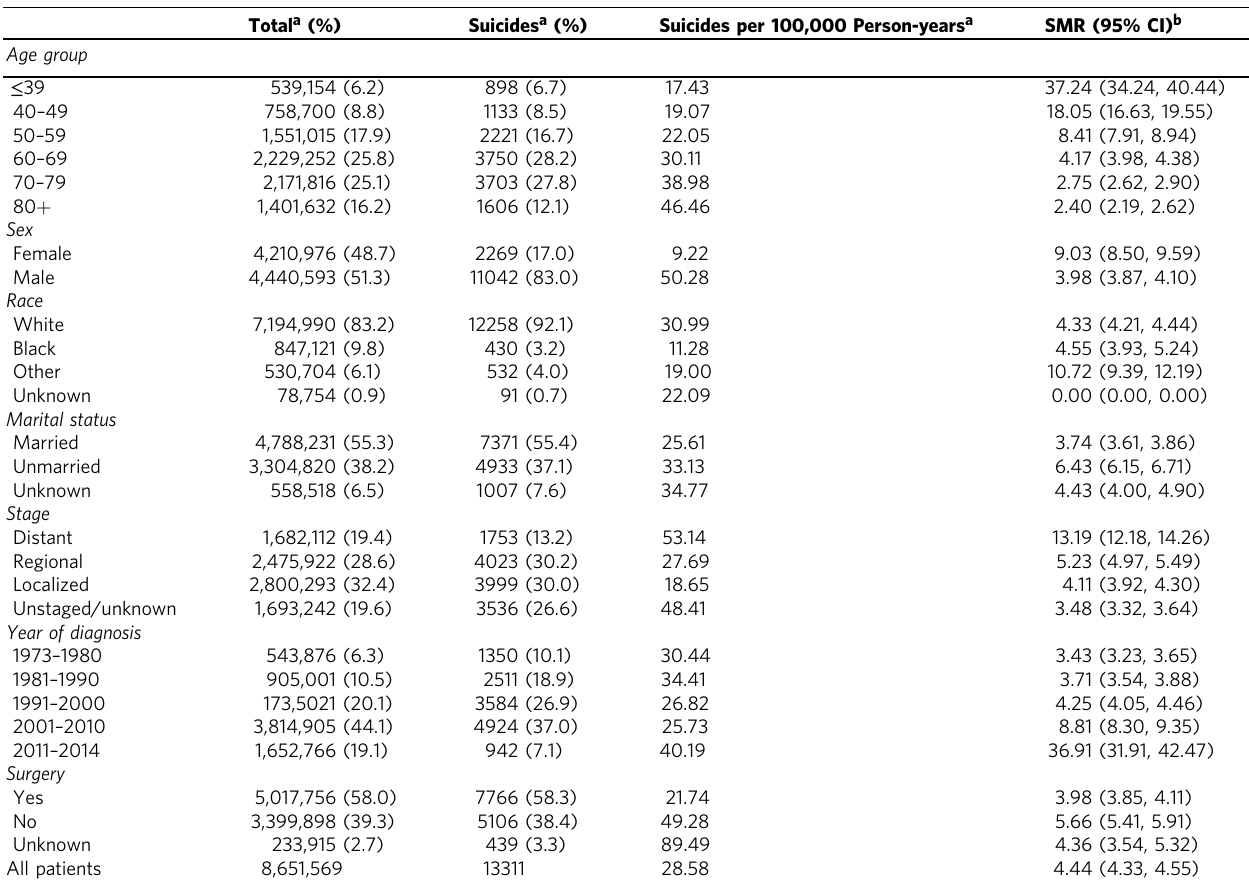
Table 1 Standardized mortality ratios of suicide among cancer patients Demographic